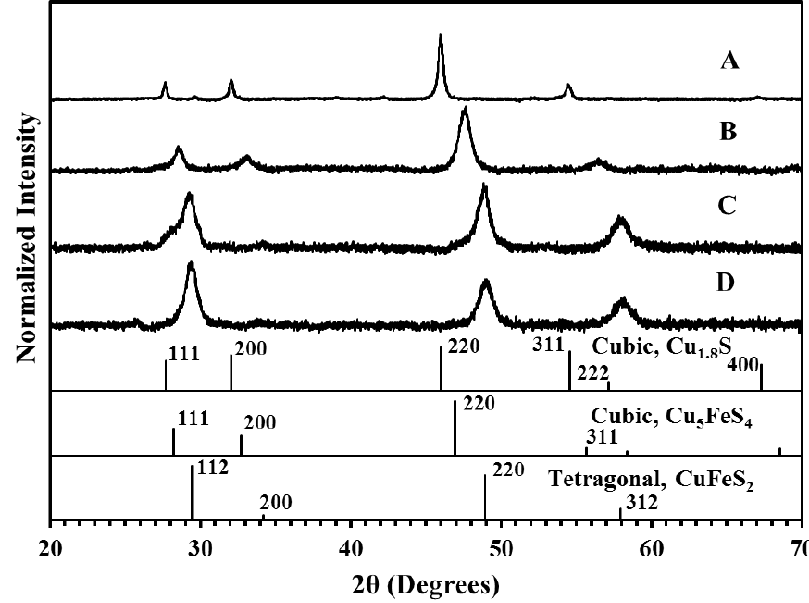
Figure 2. X-ray diffraction (XRD) patterns of nanoparticles synthesized with Cu:Fe metallic feeding ratios of ( A ) 100:0; ( B ) 70:30; ( C ) 50:50; and ( D ) 30:70 [22]. Reference patterns are for PDF card numbers 00-004-0861 (cubic Cu 1.8 S), 01-073-1667 (cubic Cu 5 FeS 4 ) and 00-001-0842 (tetragonal CuFeS 2